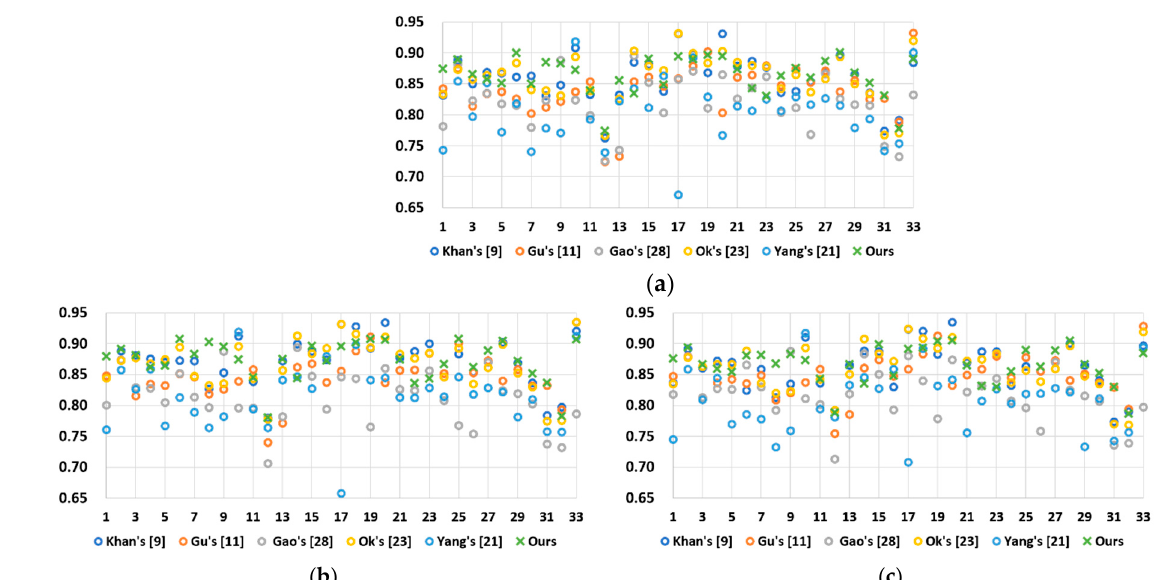
Figure 13. Overall comparison of different methods using the test images in [29]. (a ) Result of FSITMr_TMQI. ( b ) Result of FSITMg_TMQI. ( c ) Result of FSITMb_TMQI.